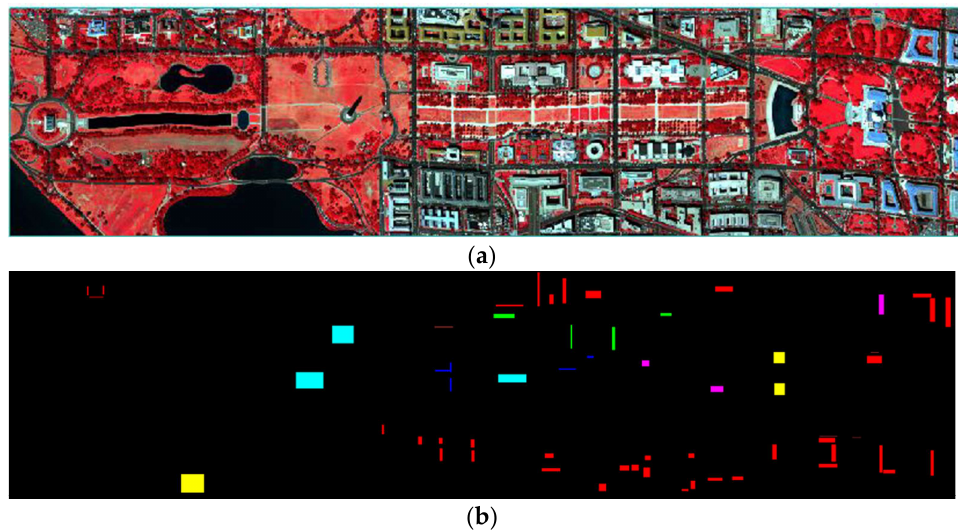
Figure 4. False-color composite map of Washington DC Mall and ground truth information: ( a ) False-color composite image; ( b ) Ground truth image. Table 3. Land category and sample size of Washington DC Mall data set.